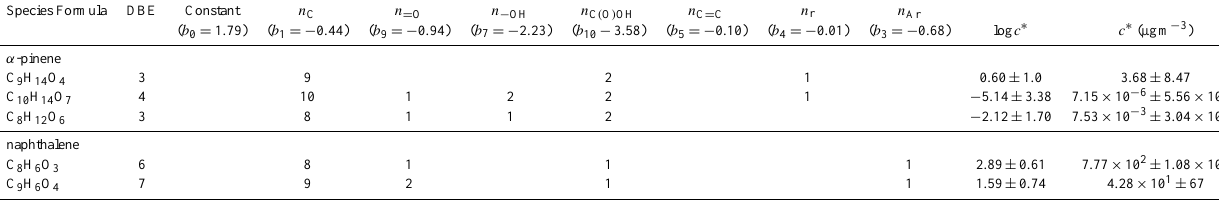
Table 2. Examples of detected species, their double bond equivalencies (DBE = 1 + n C − 1 based on the number of each type of functional group, n k . Note that DBE = n =O + n C ( O ) OH + n C = C + n r + 4 × n Ar . Values in parentheses are the SIMPOL group contribution coefficients for the corresponding functional group (Pankow and Asher, 2008). Underneath each type of functional group, the associated additivity constant is shown. Errors are calculated based on the method detailed in the Supplement. Species Formula